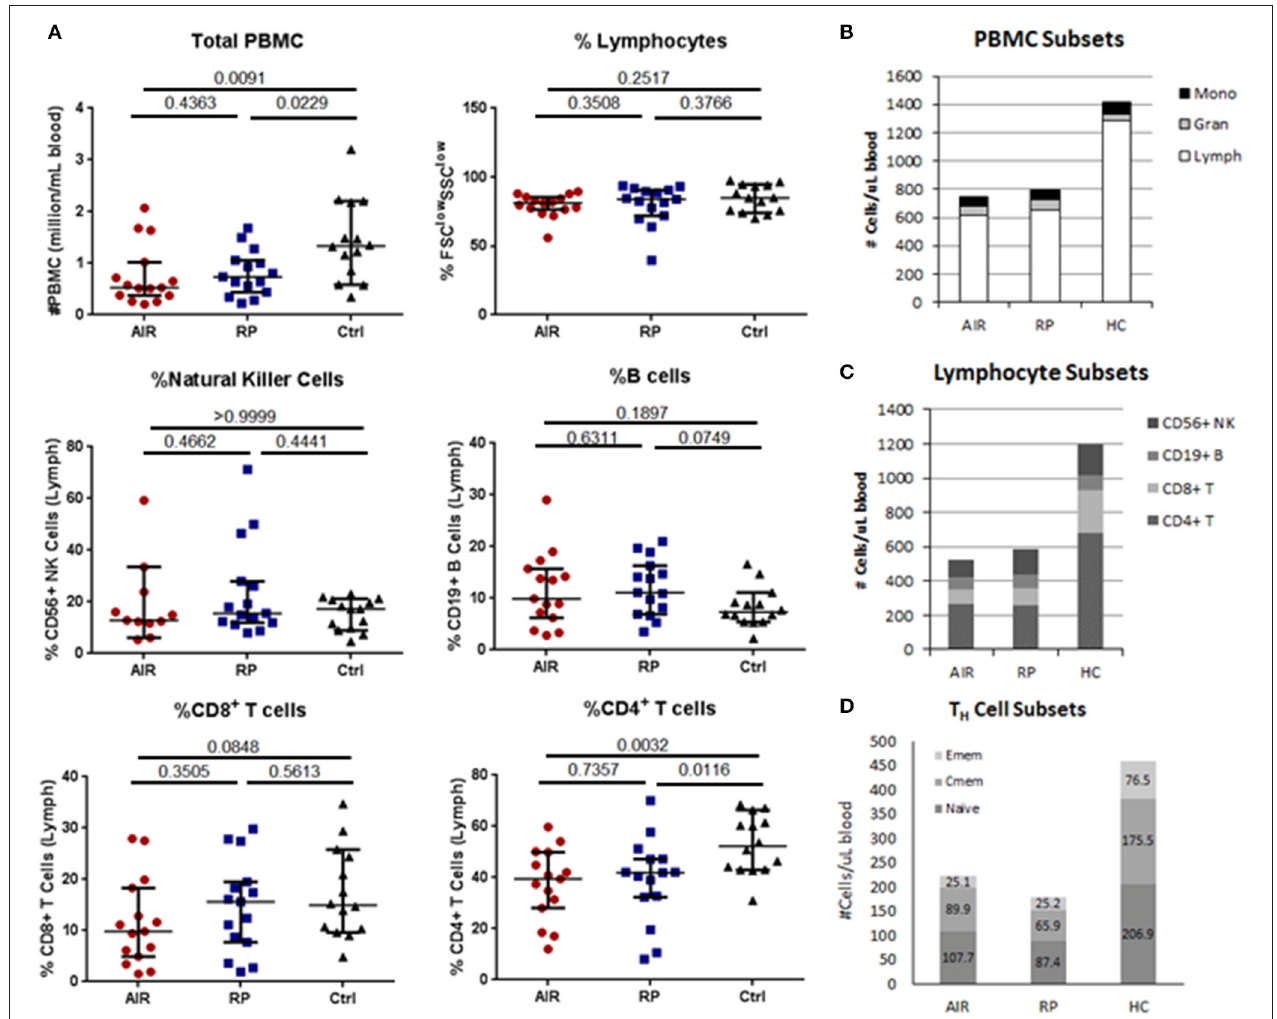
FIGURE 4 | Comparison of major lymphocyte subsets in blood of AIR or RP patients and controls . Isolated PBMC from 15 AIR patients, 15 RP patients and 14 healthy controls were counted and stained with fluorochrome-conjugated antibodies specific for human CD3, CD4, CD8, CD56, and CD19 (A–C) . (A) Peripheral blood mononuclear cells were counted using trypan blue and then stained for flow cytometry. Lymphocytes were gated as small, non-granular cells using forward scatter and side scatter. Percentages of CD56 + CD3 neg natural killer cells, CD19 + CD3 neg B cells, CD8 + CD3 + cytotoxic T cells, and CD4 + CD3 + T helper cells within the lymphocyte gate were determined for each individual. Horizontal lines mark the median and 95% confidence intervals for each group. Exact P -values from Mann-Whitney tests are shown below the title of each graph. (B) The percentages of lymphocytes, monocytes and granulocytes were determined using forward scatter and side scatter and multiplied by total PBMC counts to determine the number of each cell type per microliter of blood. Stacking bars represent the mean for each patient group. (C) Bar graph of average numbers of lymphocytes in each subset which were determined by multiplying the percentages and total lymphocyte counts for each sample. (D) A separate staining panel consisting of antibodies against CD3, CD4, CD8, CD45RA, CD45RO, and CCR7 was used to find percentages of naïve, central memory and effector memory T helper cell subsets (see Materials and Methods for criteria) which were multiplied by total numbers of CD4 + CD3 + T H cells in each